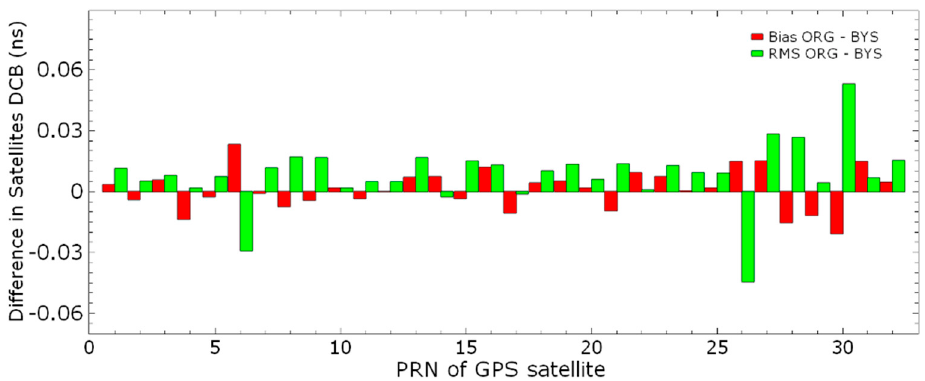
Figure A3. Differences of VTEC maps between ORG and BYS approaches.